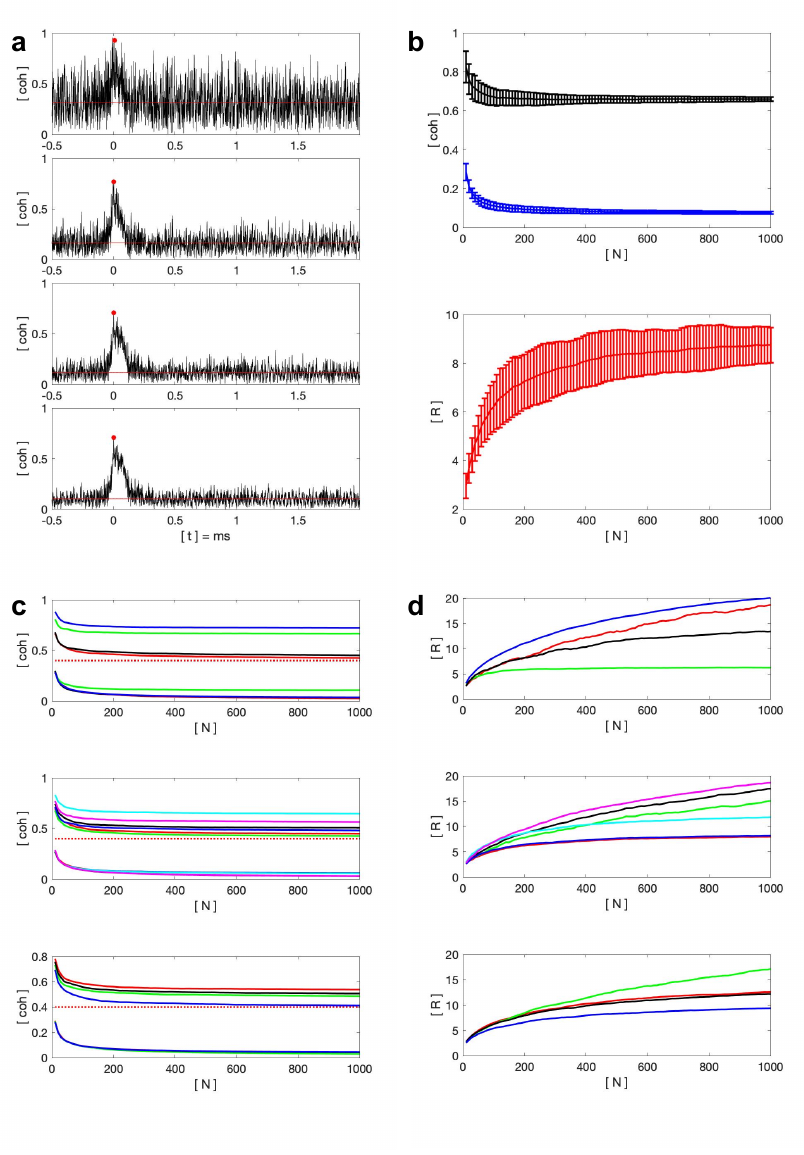
Figure 2. ( a ) An example of coherency waveforms calculated over randomly selected individual events with the case numbers 10, 40, 70, and 100. ( b ) The peak coherency (black), threshold coherency (blue), and ratio R (red) with different event numbers. ( c ) coherency based on different receiver pairs. The peak coherency are the lines larger than 0.4 while the threshold coherency are the lines lower than 0.4. The threshold value of 0.4 is marked with a red dashed line. ( d ) Ratio R values with different selections of receiver locations. In both ( c , d ), the upper figure shows the coherency at Bath (red), Toulouse (green), Orleans (black), and Rustrel (blue). The middle figure shows the coherency for the location pairs Bath–Toulouse (red), Bath–Orleans (green), Bath–Rustrel (black), Toulouse– Orleans (blue), Toulouse–Rustrel (sky blue), and Orleans–Rustrel (purple). The bottom figure shows the coherency for the location sets Toulouse–Orleans–Rustrel (red), Bath–Orleans–Rustrel (green), Bath–Toulouse–Rustrel (black), and Bath–Toulouse–Orleans